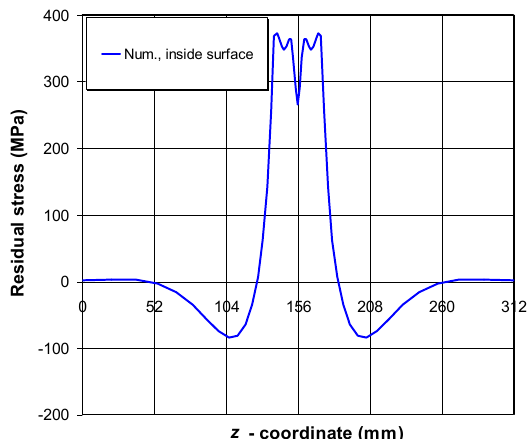
Figure 11. Axial residual stress distribution on outside surface of welded pipes along line z 1- z 2 (Figure 2), α = 270°.